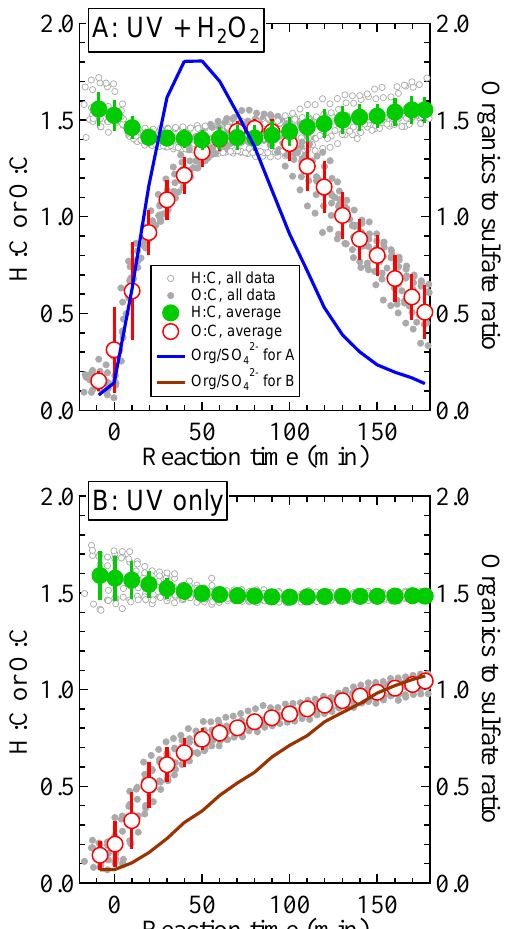
Fig. 3. H:C and O:C ratios as a function of time under condi- Figure 3. H:C and O:C ratios as a function of time under conditions (A) and (B). Also shown are the 2 tions (A) and (B). Also shown are the 10min running average ratios 10-minute running average ratios of organics to sulfate (solid lines) under these two conditions. 3 of organics to sulfate (solid lines) under these two